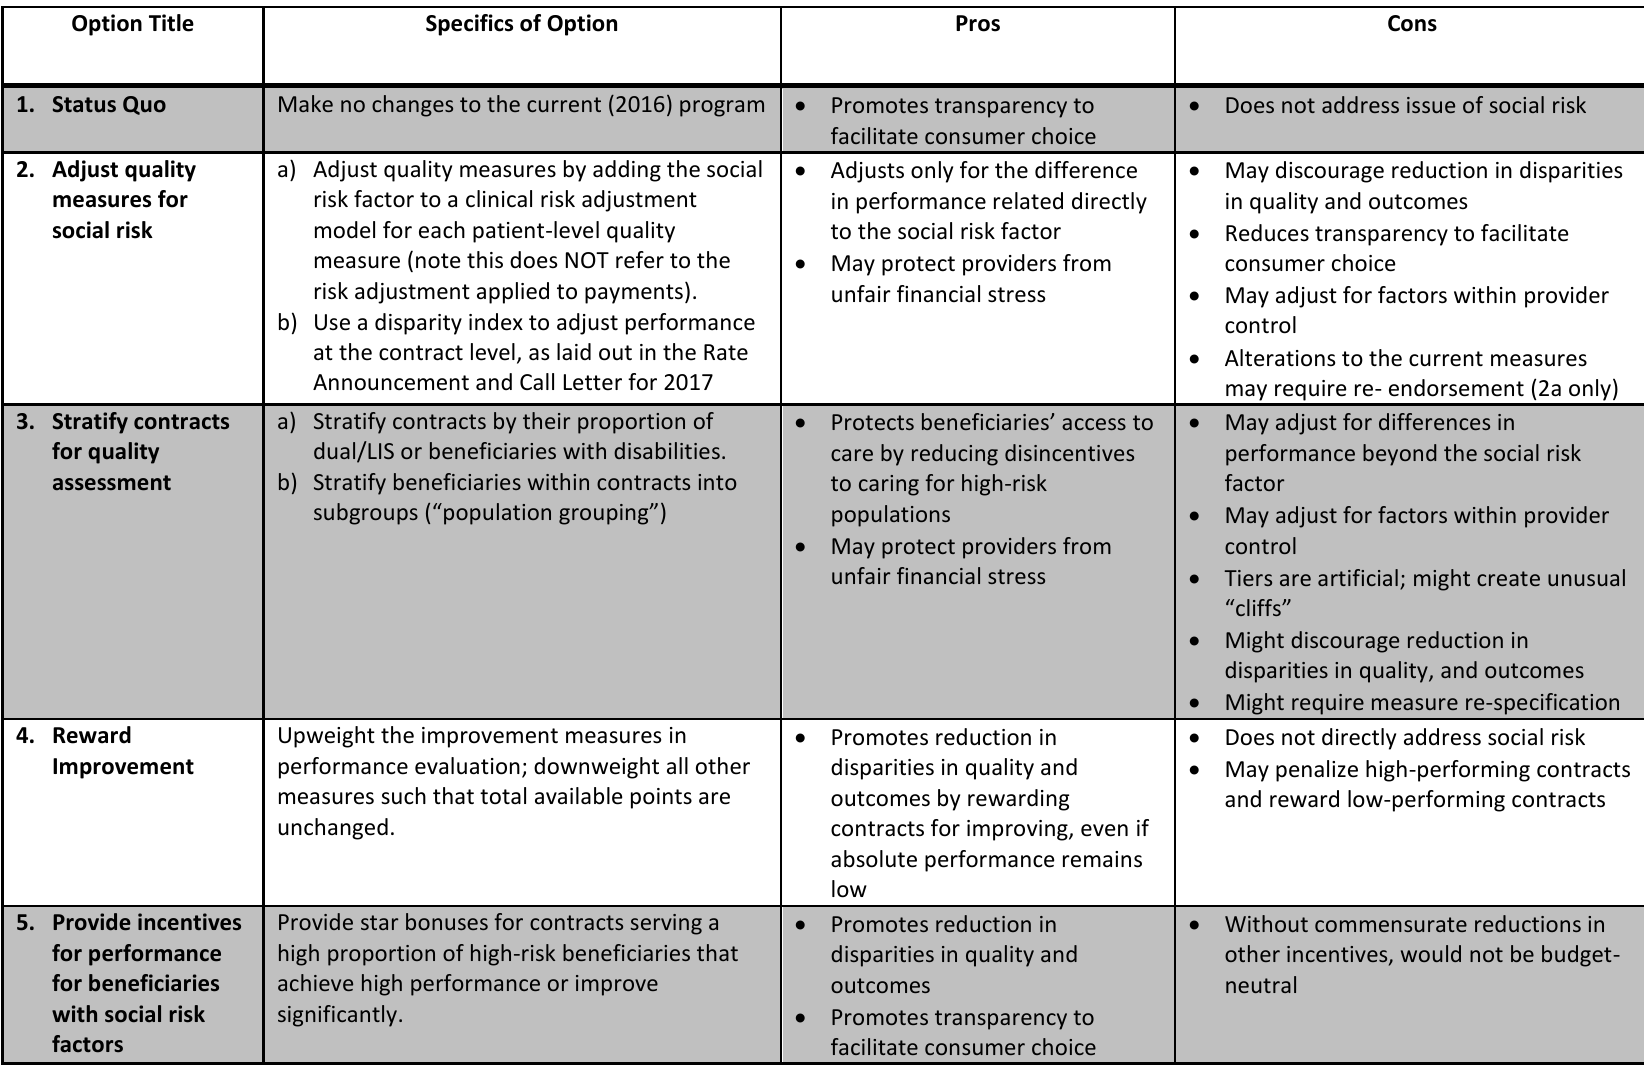
Table 8.8: Summary of Policy